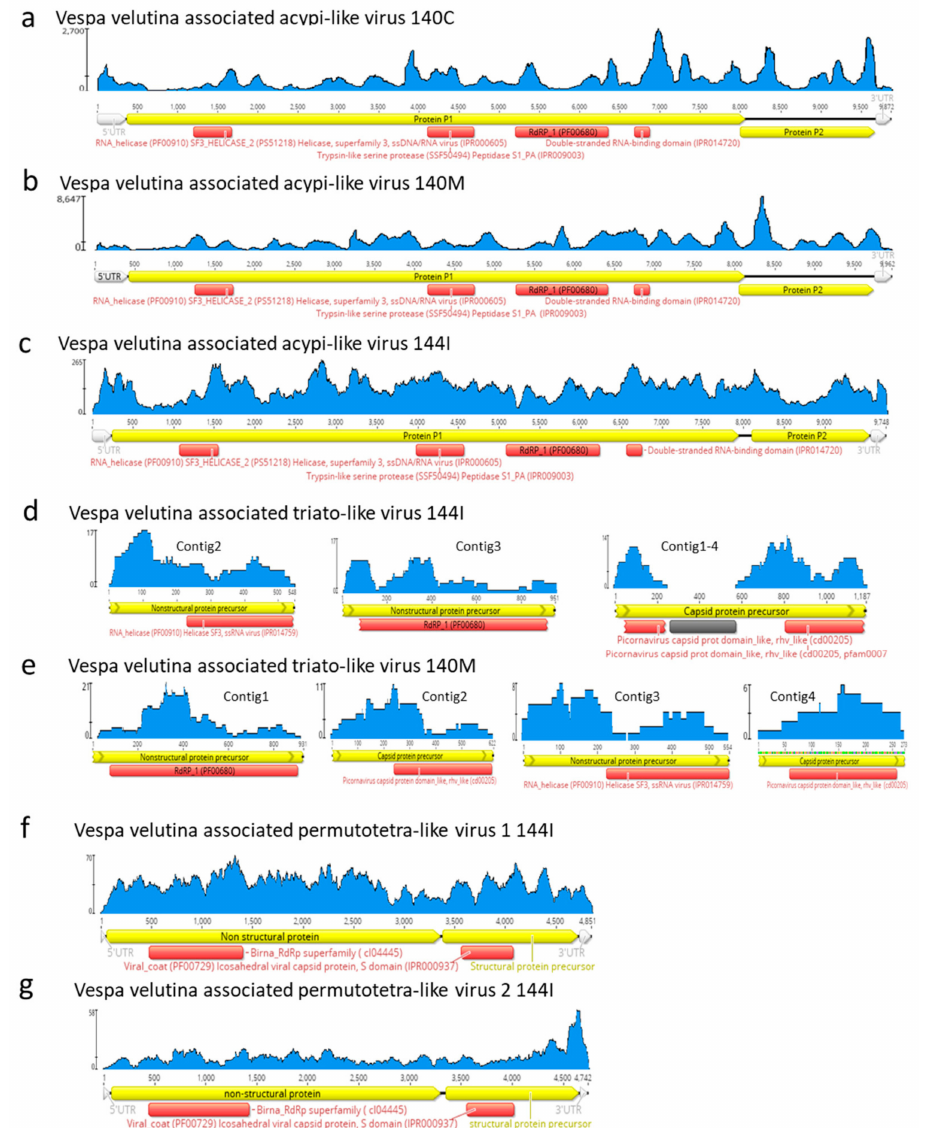
Figure 4. Schematic representation, coverage and annotation of the complete or partial genomes of insect RNA viruses found in hornets. ( a – c ) Vespa velutina associated acypi-like virus; ( d – e ) Vespa velutina associated triato-like virus and ( f – g ) Vespa velutina associated permutotetra-like virus 1 and